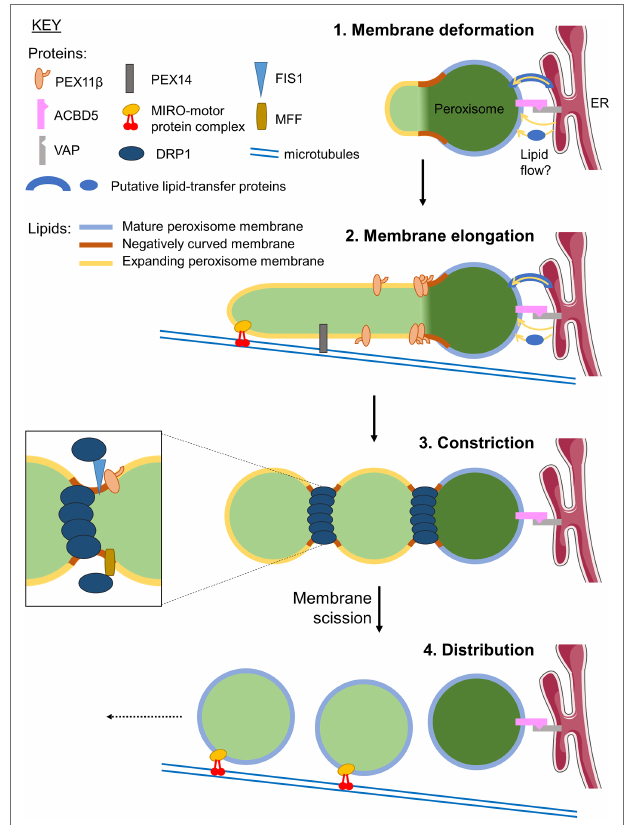
FIGURE 1 | Growth and division of mammalian peroxisomes. Schematic showing the mechanism of peroxisome proliferation via a cycle of growth and division from pre-existing peroxisomes. Initially, the peroxisomal membrane deforms (1), with areas of membrane transitioning from positive to negative curvature to establish a protrusion. This protrusion then elongates, supported by lipid flow from the ER at ACBD5-VAP-mediated membrane contacts, via an unknown mechanism that may involve lipid transfer proteins. It is currently unclear whether the membrane composition of the protrusions, that will